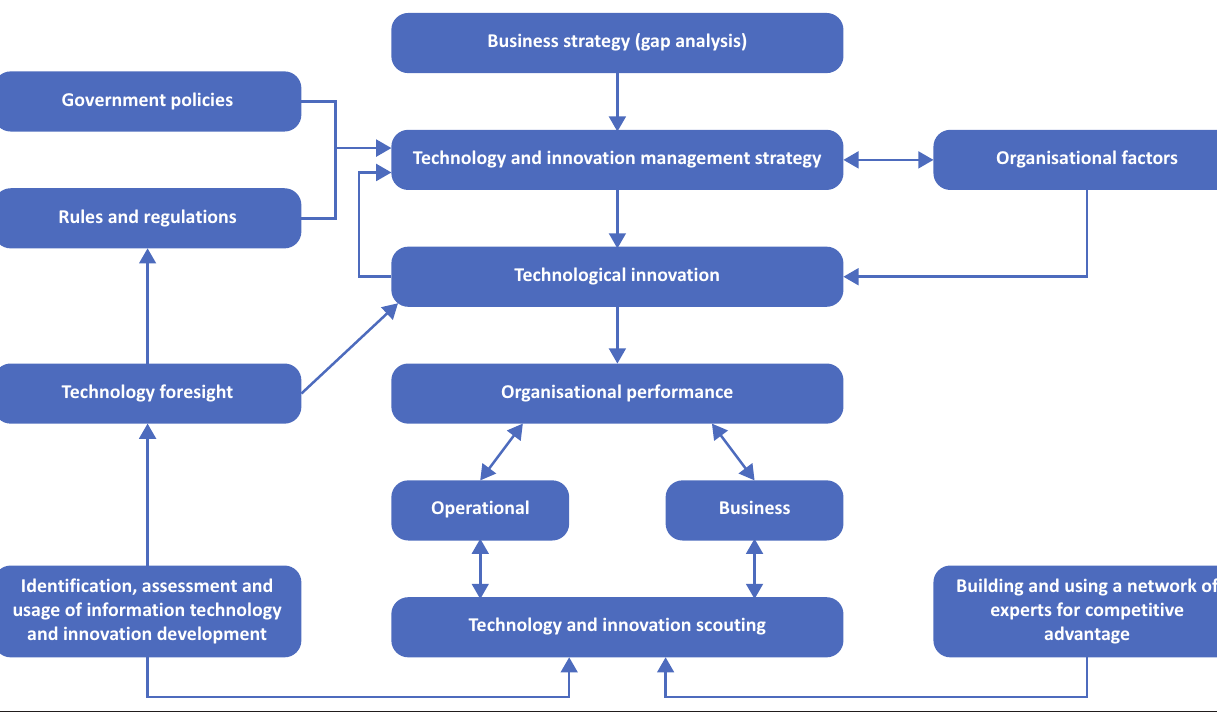
FIGURE 4 : Technology and innovation management strategy